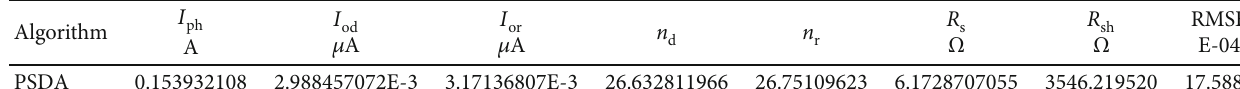
Table 4: The seven parameters of the LSM 20 photovoltaic